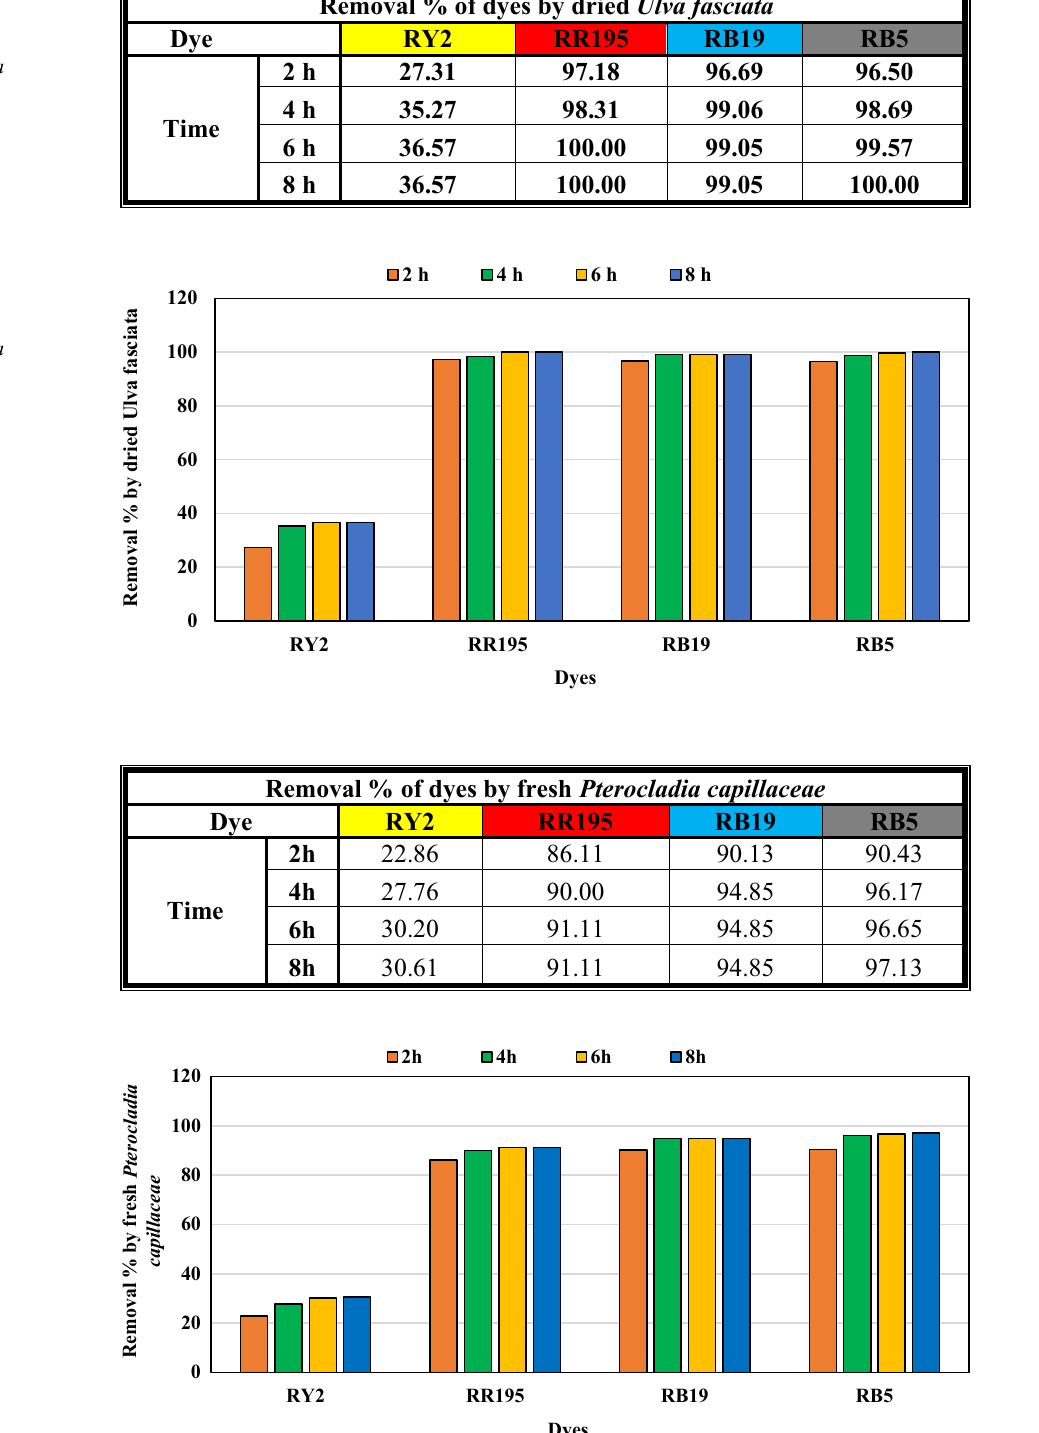
(at optimized conditions) on the removal percentages of the four studied dyes by dried Ulva fasciata